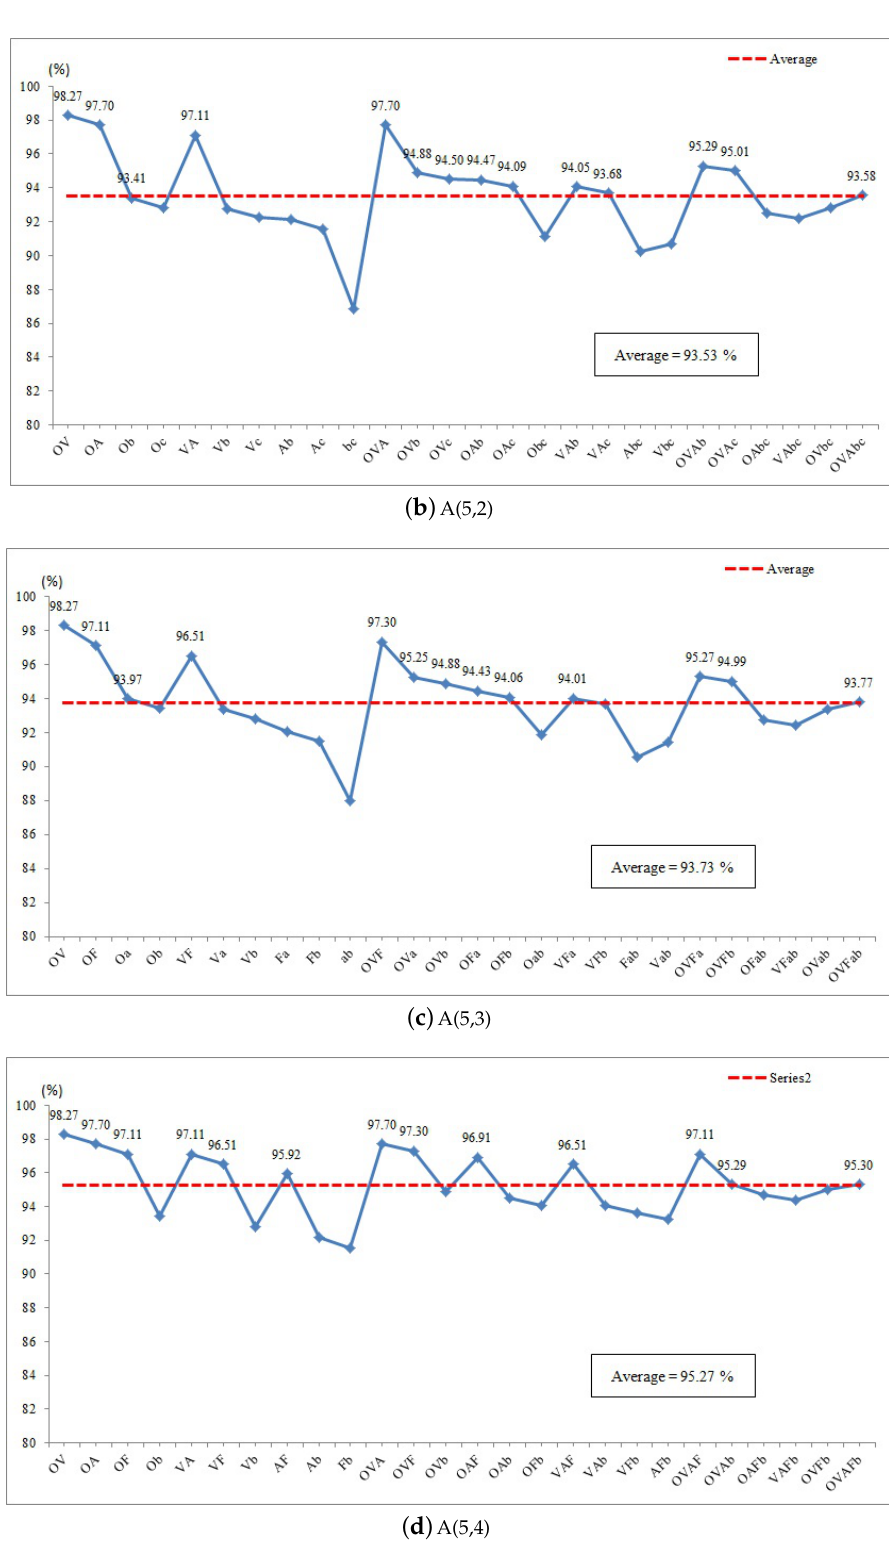
Figure 10. Performance of the combination of 5-features sets (A group) using